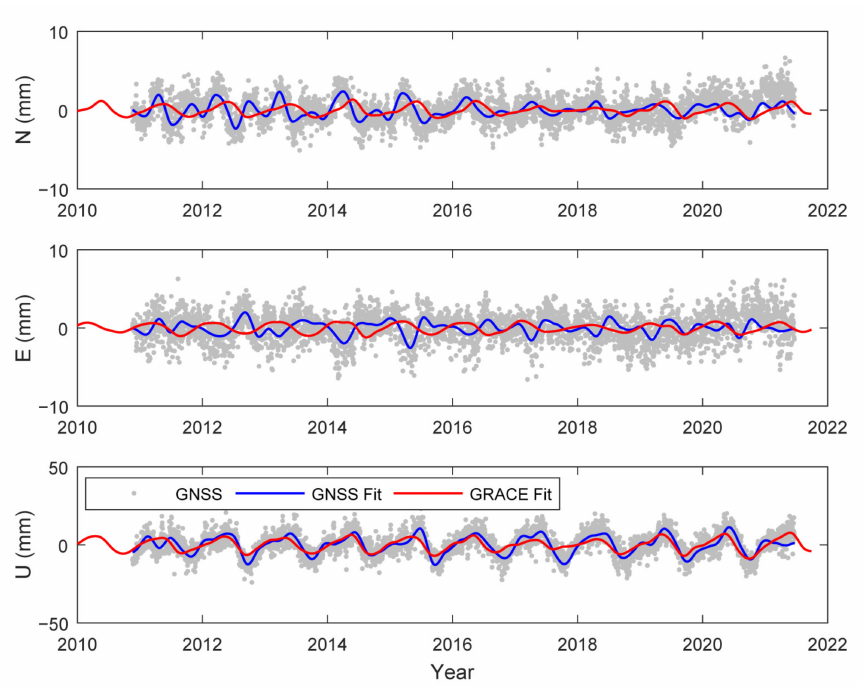
Figure 7. GNSS and GRACE time series of SCPZ